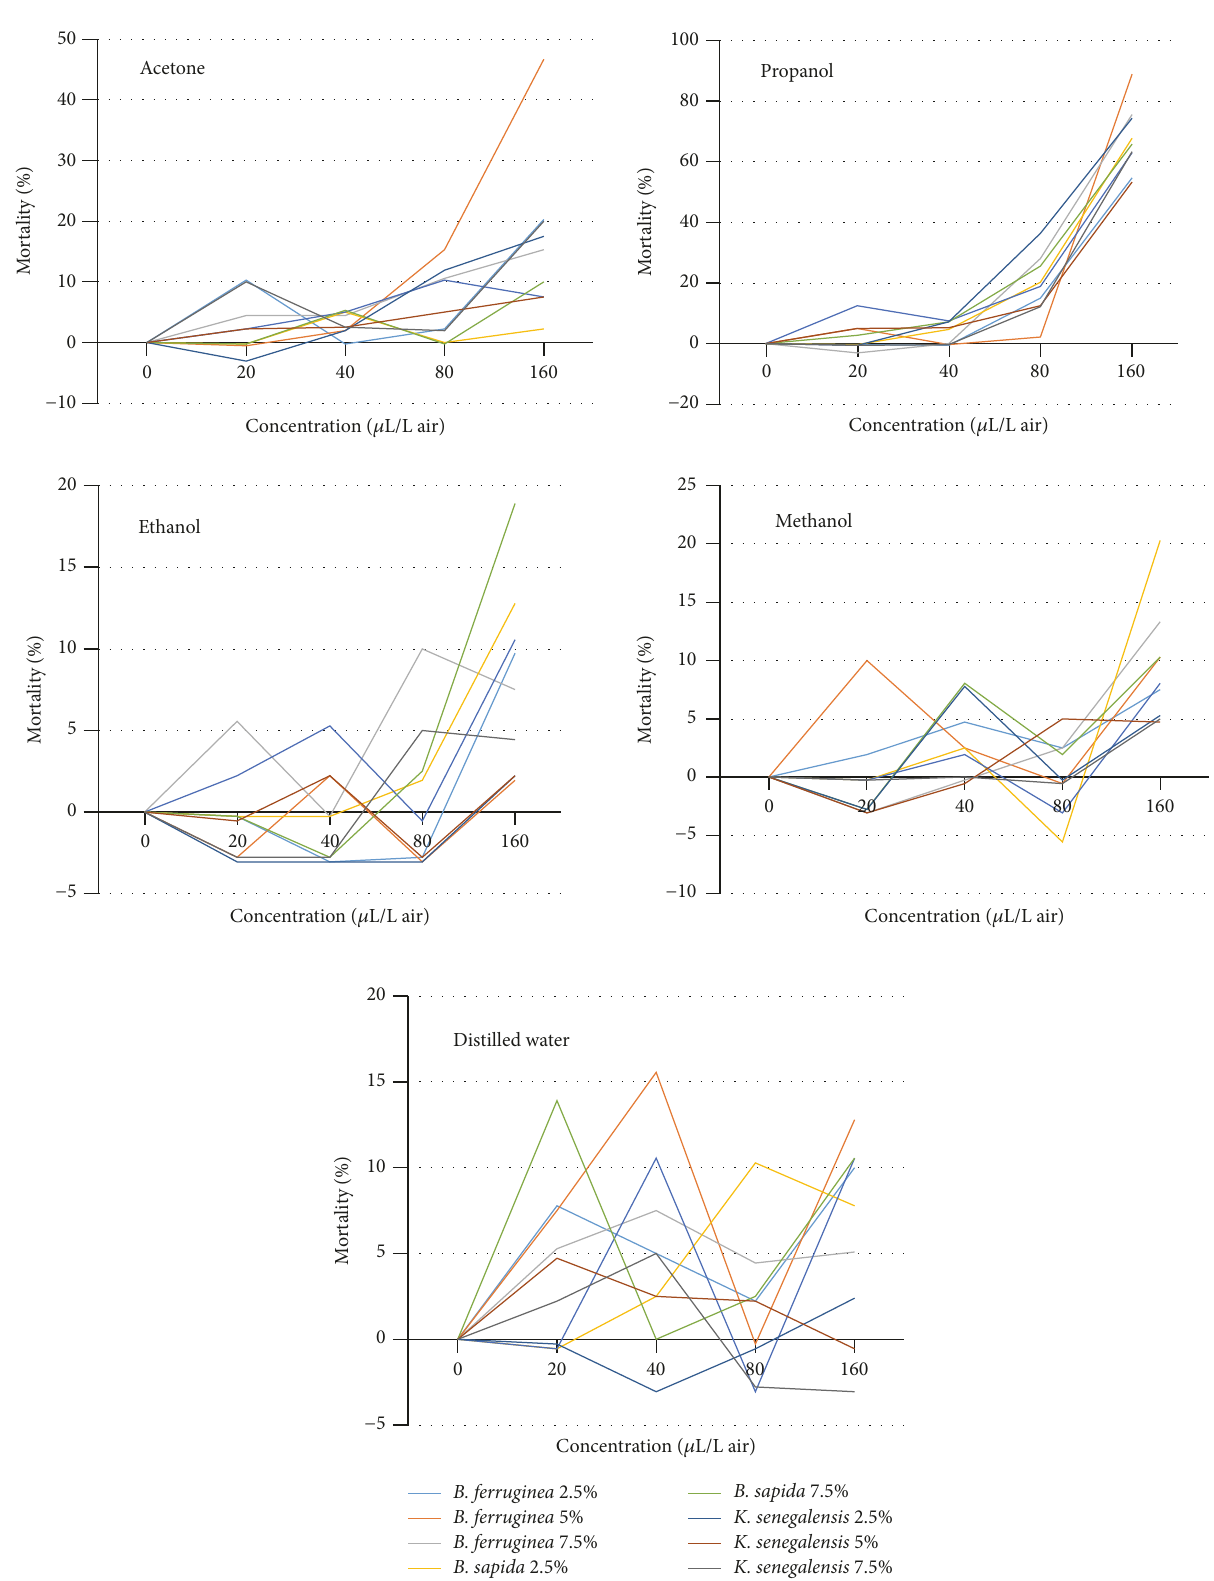
Figure 1: Percentage adult mortality of D. porcellus 24 hours after treatment with acetone, propanol, ethanol, methanol, and aqueous extracts of B. ferruginea , B. sapida , and K. senegalensis . Mortality rate was corrected using Abbott’s formula